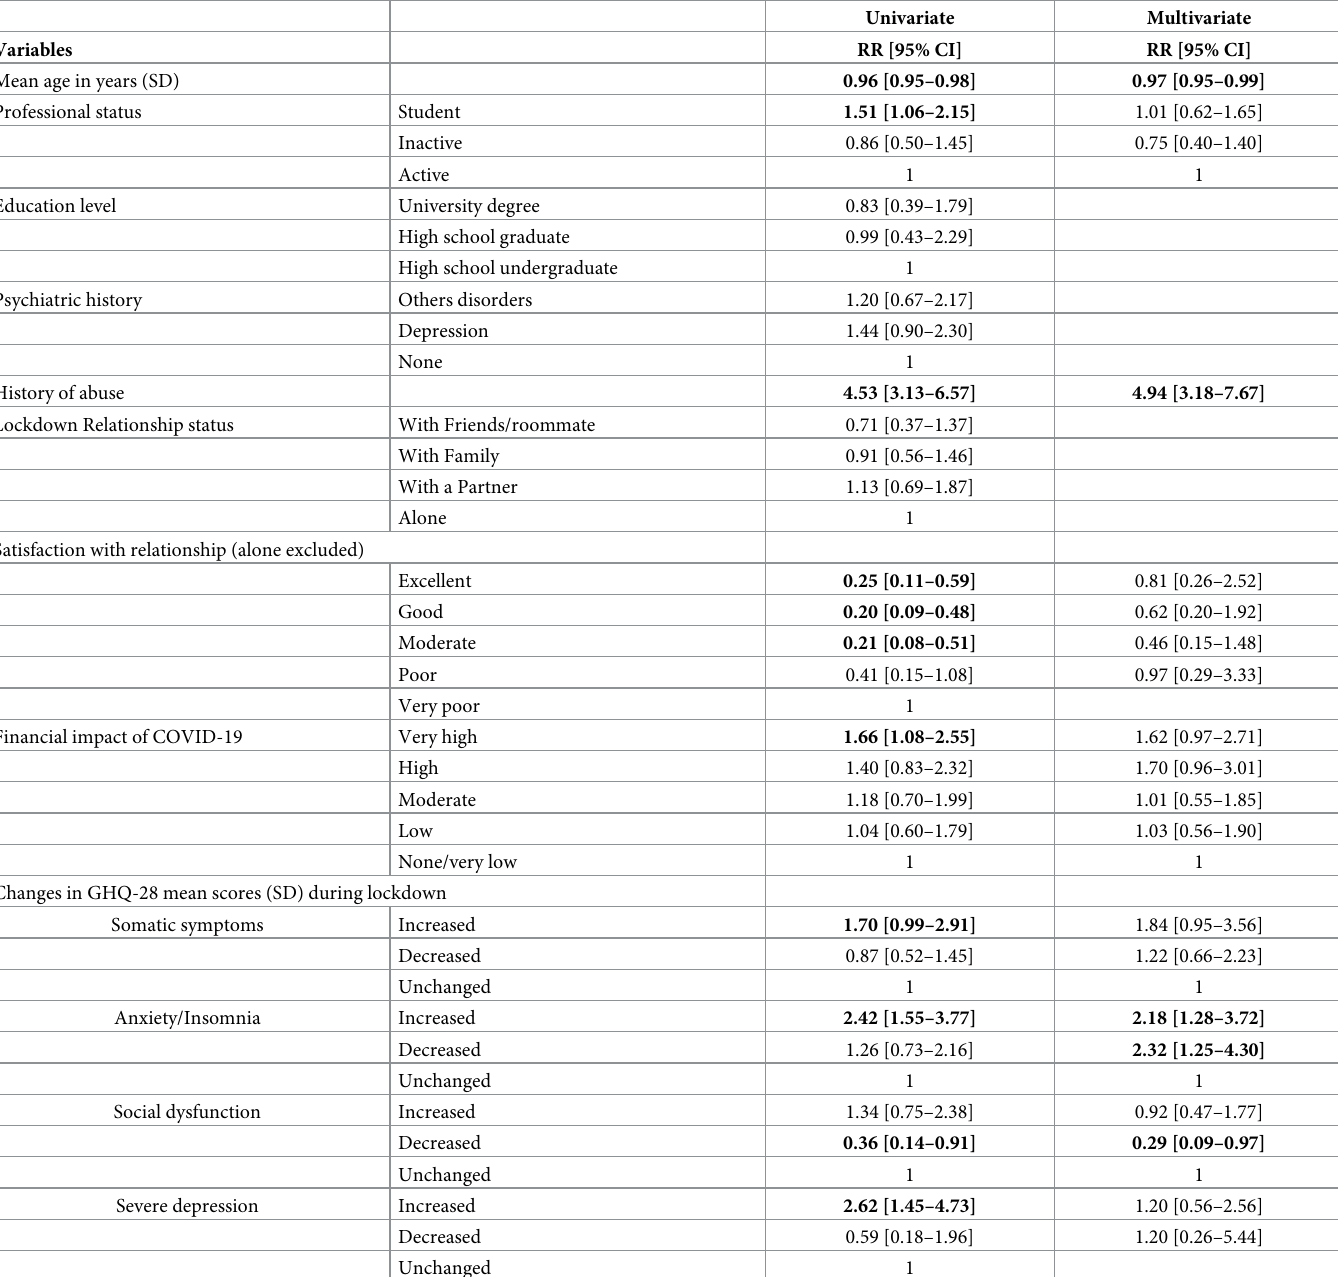
Table 4. Rate ratios and 95% confidence intervals (RR [95% CI]) of the number of reported experiences of violence/assault post first lockdown (N = 1538); Poisson regression.